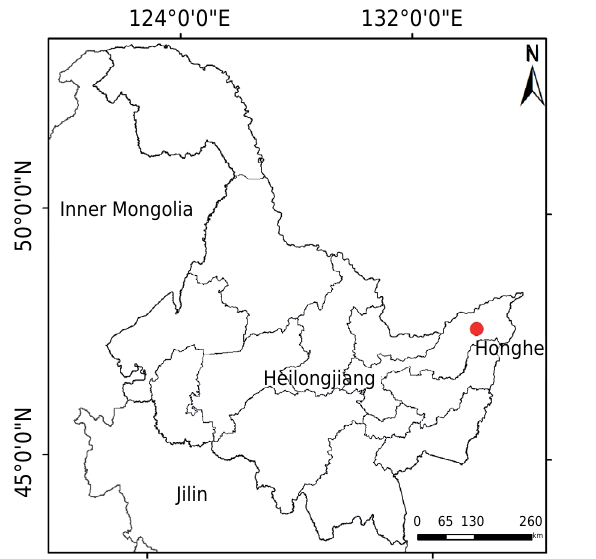
Figure 1. The map Honghe Nature Reserve (47° 45' 39" N, 133° 37' 04" E) of the Sanjiang Plain wetland in Heilongjiang